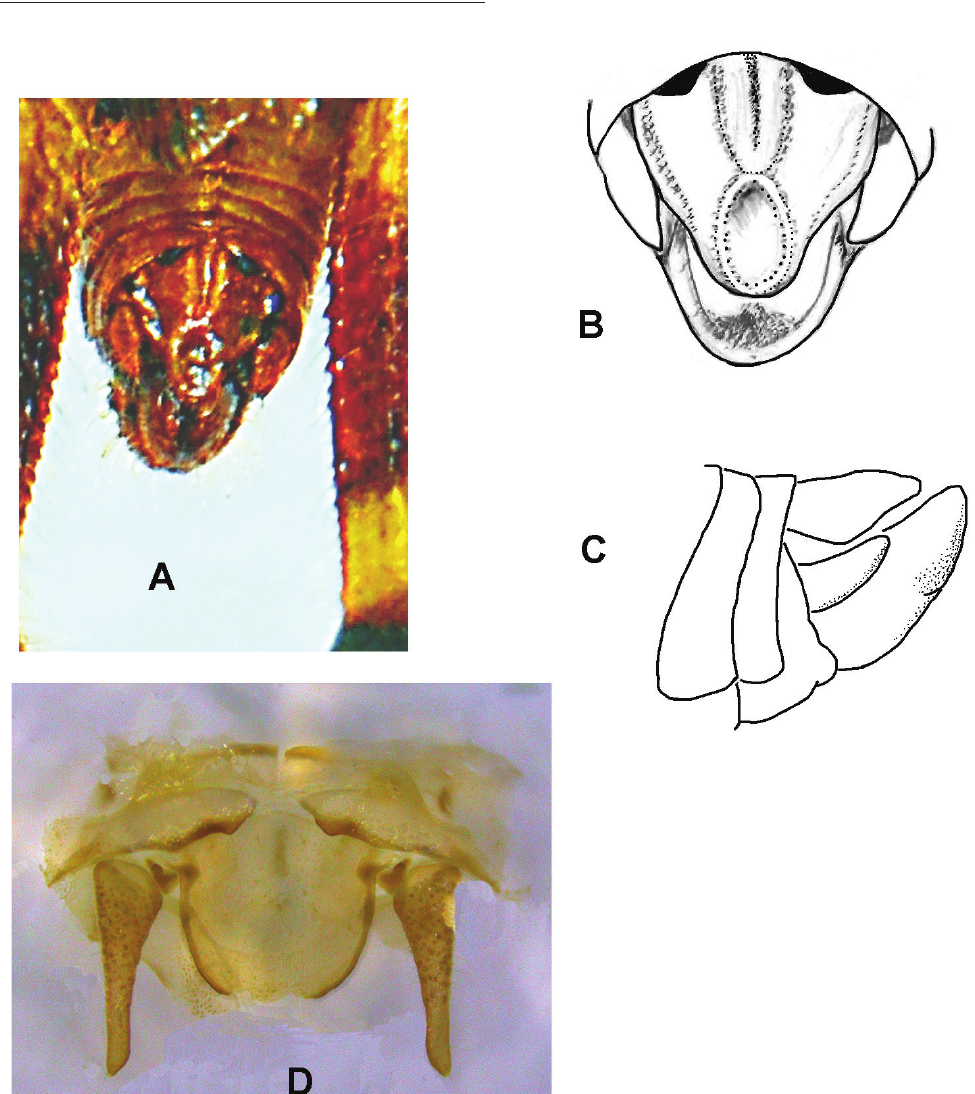
Fig. 5. Male terminalia of Mopla guttata . A . Dorsal aspect of pinned specimen; B. Interpretive drawing of A ; C. Lateral view; and D. Cleared preparation of abdominal tergites 10 and 11. Note that the terminal lobe of the supraanal plate is missing; compare with A and B. Furcula and the obliquely truncate cerci are clearly